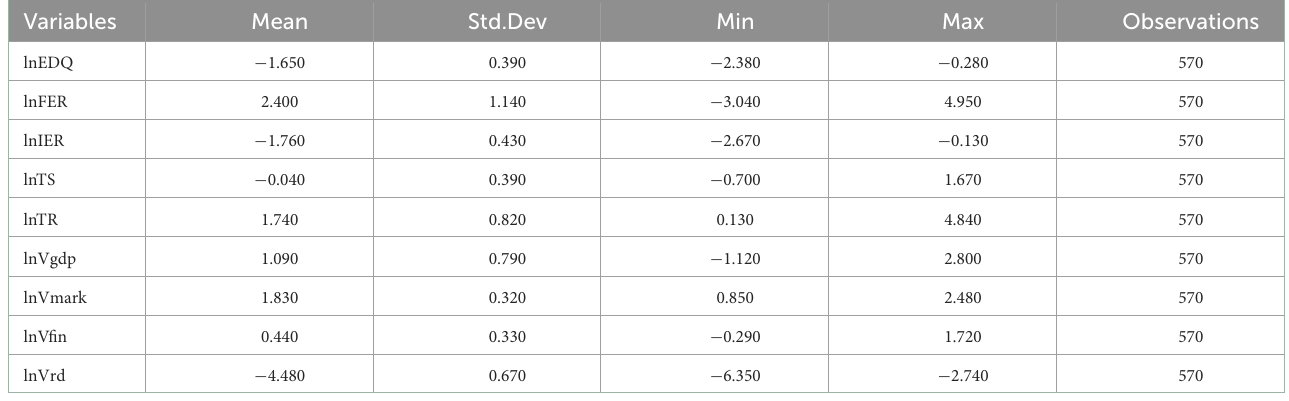
TABLE 2 Variables’ descriptive statistics.